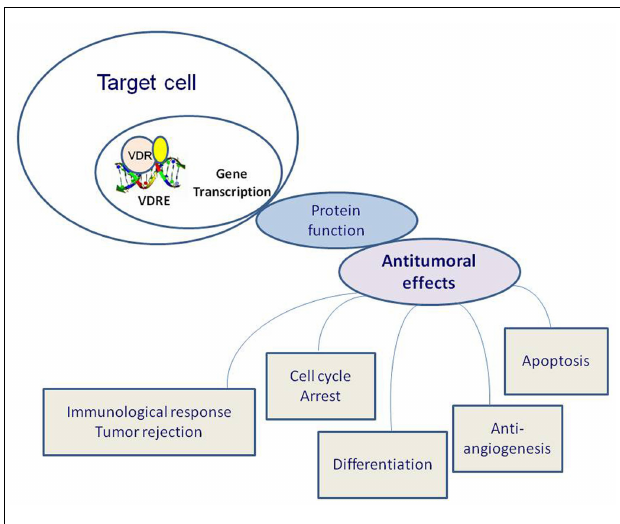
FIGURE 2 | Effects of vitamin D receptor (VDR) activation on tumorigenesis. Calcitriol bound toVDR forms heterodimers with the retinoid X receptor (RXR) and its ligand (9 cis -retinoic acid), these dimers occupy specific nucleotide sequences: vitamin D response elements (VDREs). In conjunction with several transcription factors, this complex lead to the transcription of vitamin D responsive genes. or phosphatidylinositol-3-kinase (PI3K). There are a number of